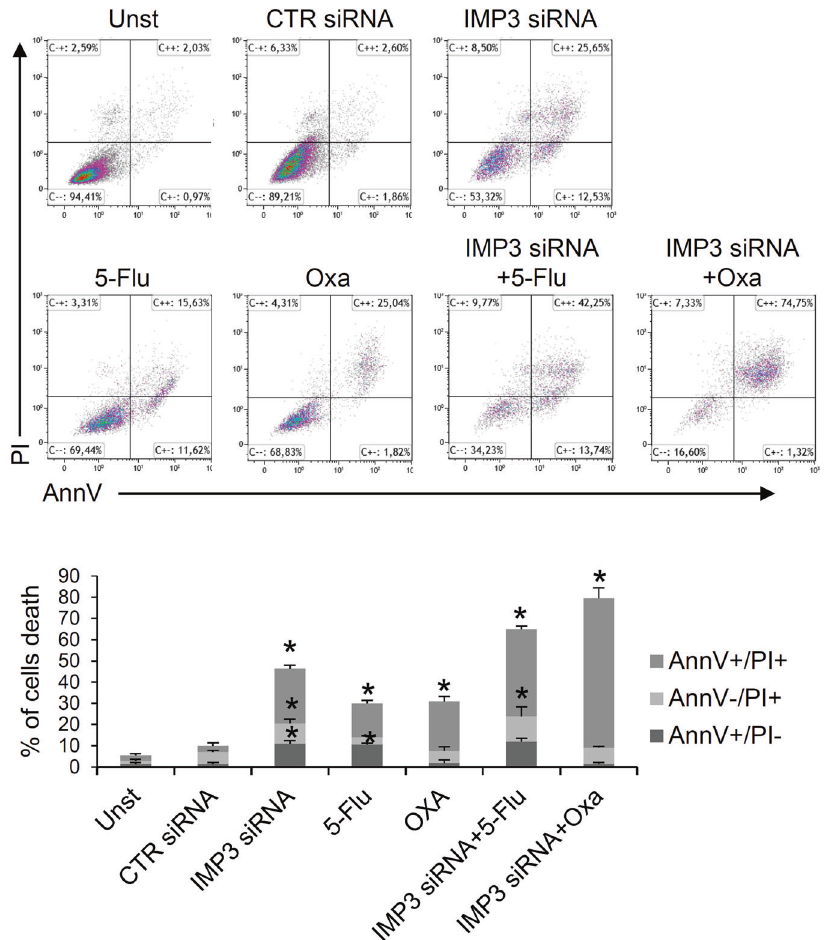
Fig. 3 IMP3 knockdown enhances the toxicity of chemotherapeutic drugs. Representative dot-plots (upper panels) and quati fi cation percentage (lower panel) showing the AnnexinV- and/or propridiun iodide (PI)-positive HCT-116 cells pre-incubated with control or IMP3 siRNA (both fi nal concentration 25 nM) for 12 h and then stimulated or not with 5- fl uorouracil (5- fl u, 10uM fi nal concentration) or Oxaliplatin (oxa, 10uM fi nal concentration) for 36 h. Data indicate mean ± SEM of 2 separate experiments (CTR siRNA-treated cells versus all, * p ≤